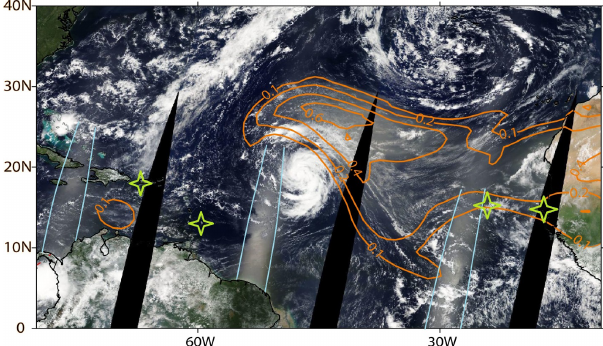
Figure 1. True-color Terra Moderate Resolution Imaging Spectro- radiometer (MODIS) satellite imagery composited on 12 Septem- ber 2012 and overlaid with NAAPS-RA 550nm dust aerosol op- tical depth (DAOD, an approximate measure of total atmospheric column of dust aerosol mass, unitless) isopleths, showing Hurri- cane Nadine’s interaction with the SAL. Hurricane Nadine is lo- cated in the middle of the image. African dust appears as a light transparent brown haze in between the African coast and Hurri- cane Nadine, as well as wrapping around the northern periphery of the storm. Note that areas of sunglint (narrow regions between the light blue curves) are similar in color to the dust aerosols but have the same orientation as the satellite orbits and are located approxi- mately midway between satellite coverage gaps (black regions ori- ented south-southwest to north-northeast). Satellite imagery cour- tesy of the MODIS flying on NASA’s Terra satellite and available from https://worldview.earthdata.nasa.gov/ (last access: 25 Novem- ber 2020). The stars in light green represent four sites used for val- idation purposes, including Dakar, Cabo Verde, Ragged Point, and La Parguera in order from east to